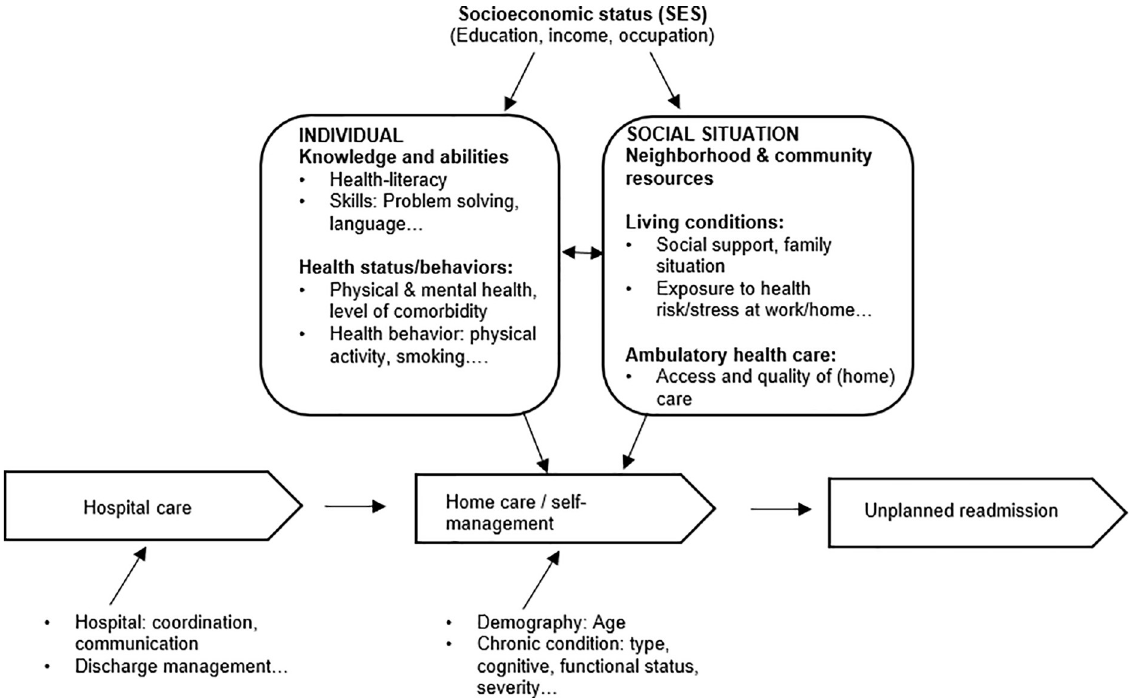
Fig 1. Conceptual framework on social determinants of health influencing self-management and hospital readmissions [13,20,27].